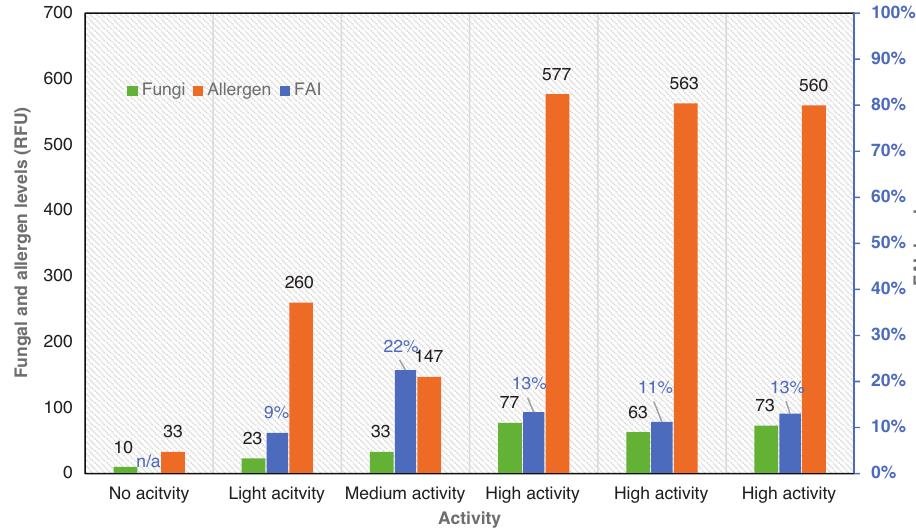
Fungal to Allergen Index (FAI), fungal and allergen levels measured from all experiments. (Source: Authors, 2022.)